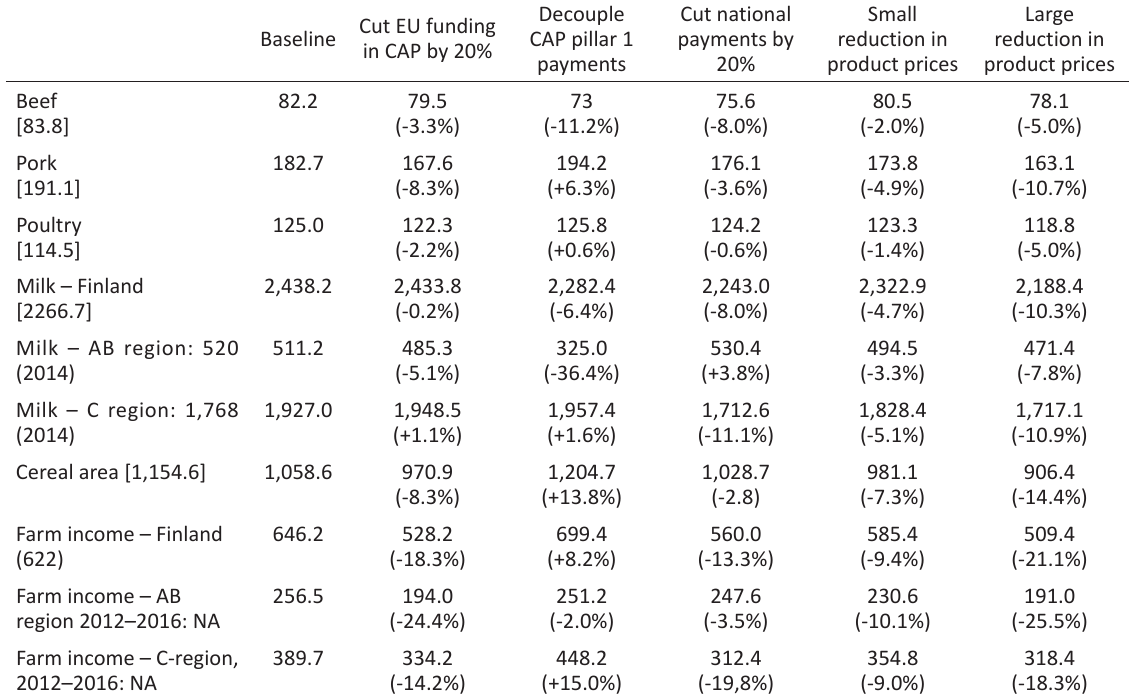
Table 3. Simulated livestock production (meat in 1000s tons, milk in million litres), land area under cereal cultivation (1000 ha) and farm income (€ million) in 2025 [observed average values for 2012–2016 are given for comparison]. Region AB = southern Finland, region C = central and northern Finland (see Figure 1)